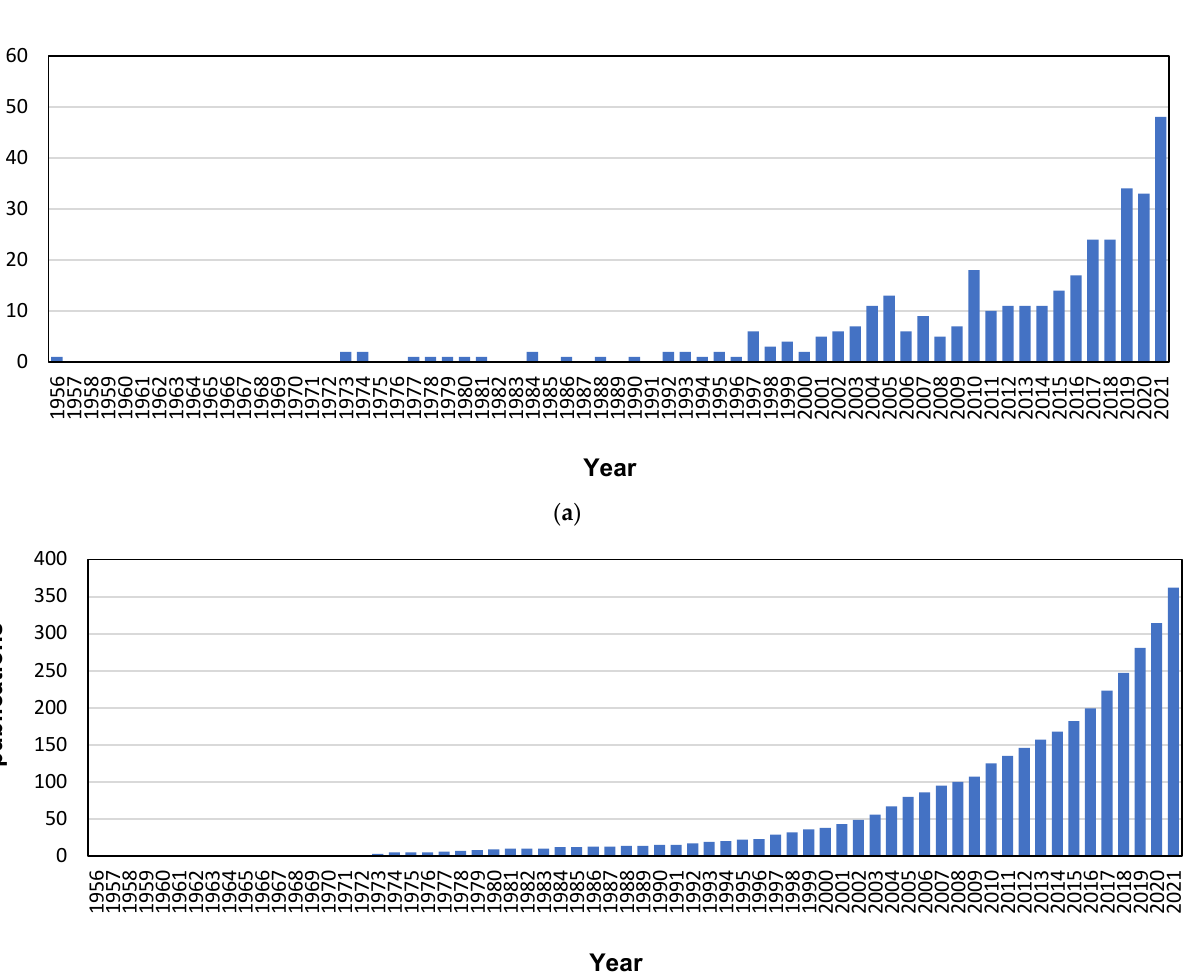
Figure 1. Annual ( a ) and accumulated ( b ) publication output.